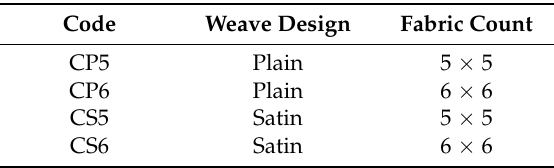
Table 3. Composition of kenaf woven in the hybrid